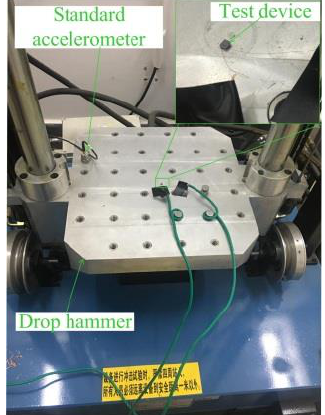
Figure 12. Dropping hammer system.